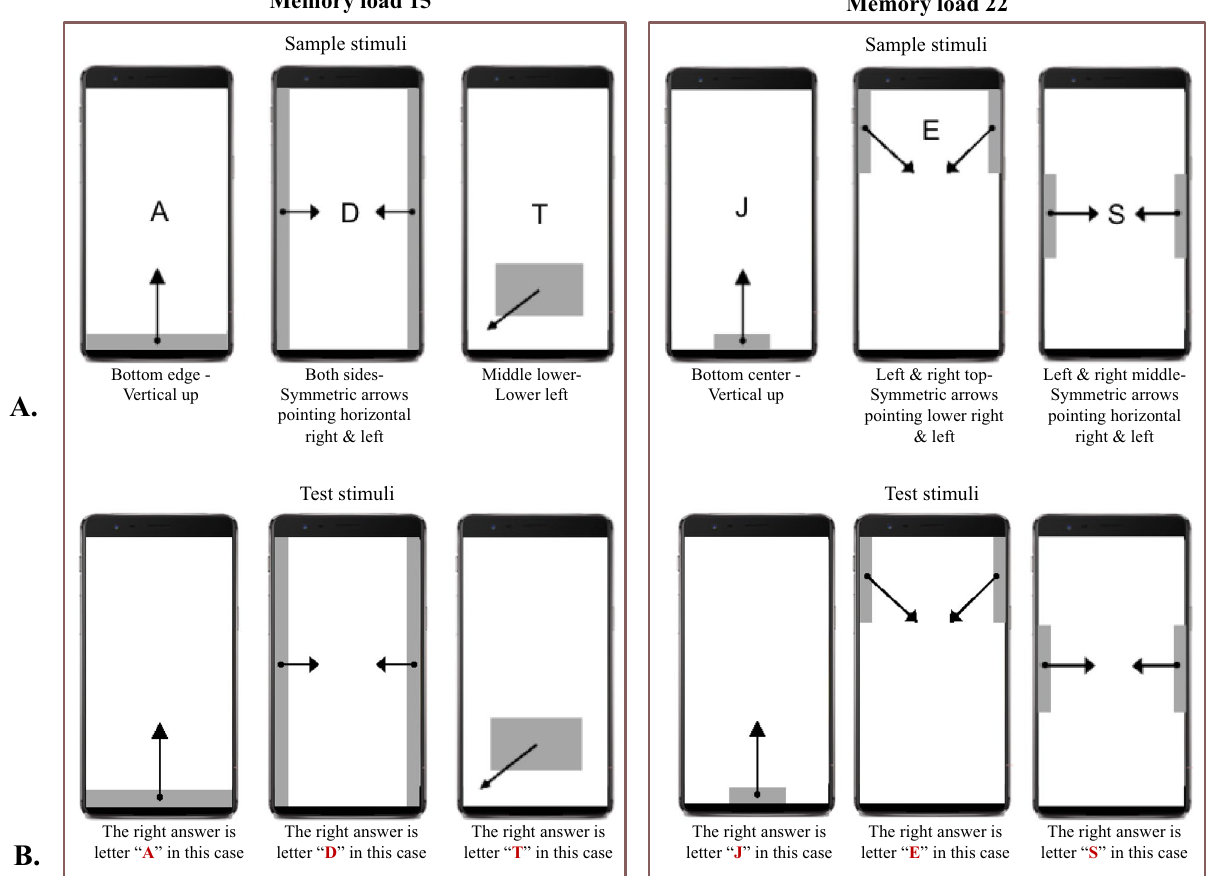
Figure 1. Examples of gesture-letter pairs in each memory load ( A ) and the related test stimuli ( B